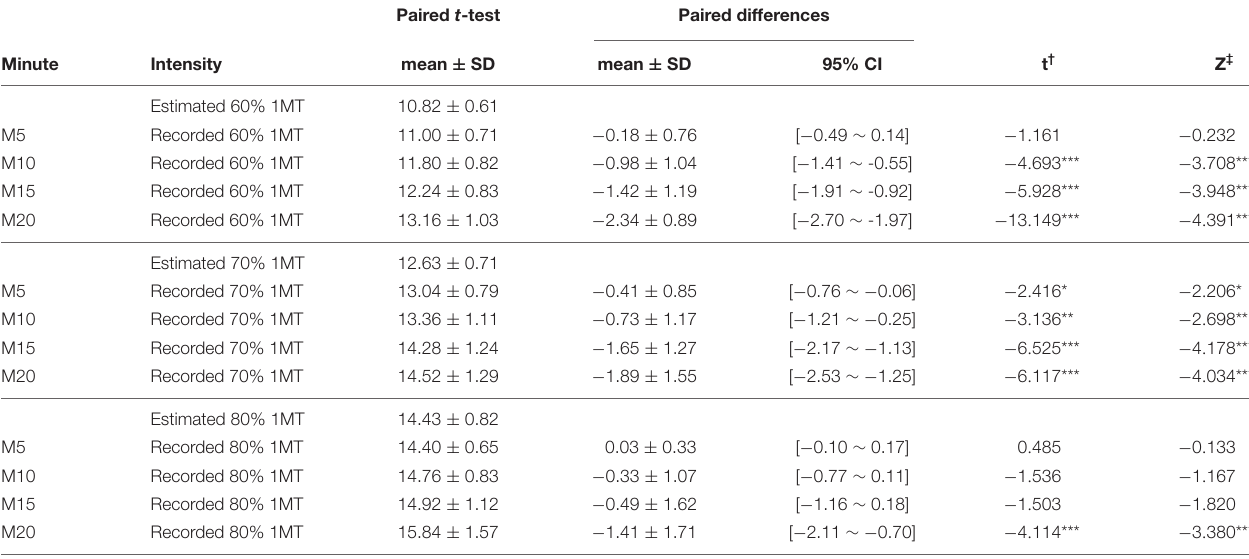
TABLE 3 | Comparison result between estimated RPE level and measured RPE level during actual exercise for three exercise intensities per 5 min in the ISO + EMS group. Paired t -test Paired differences